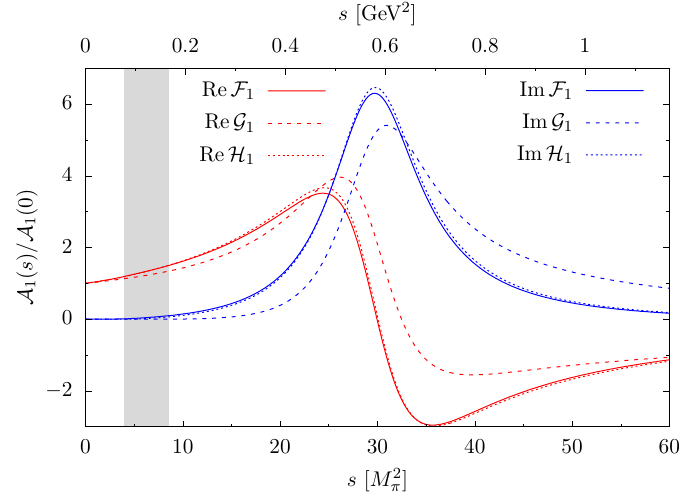
= y = 0 . From top to c c = − 0 . 95 to y max = 0 . 85 at distances c c 2 with its uncertainty band c | | 2 (blue). The 371 data points with error bars (black) were 1